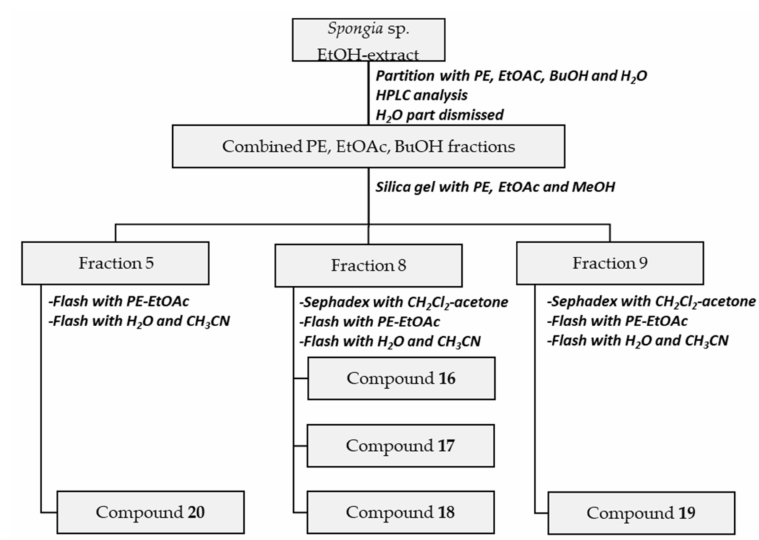
Figure 3. The isolation scheme for the Spongia sp.